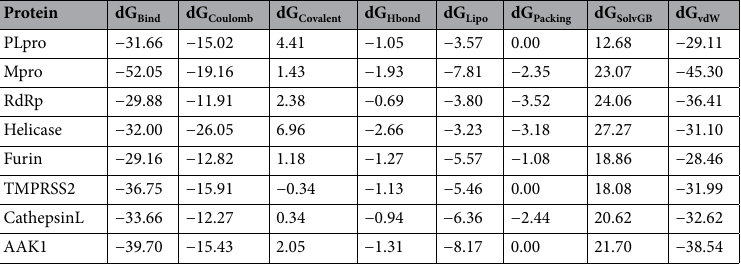
Table 3. Detailed values of the binding-free energies (kcal/mol) and binding energy states of the 8 SARS- CoV-2 target proteins that bound with (+)-usnic acid.